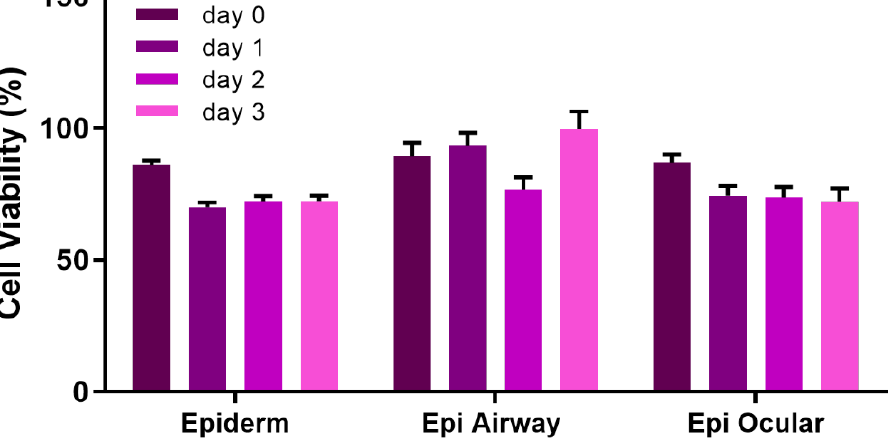
Figure 10. Viability after storage of various constructs. The indicated constructs were vitrified with DP6/VS70 in a deep-well plate and stored at < − 135 ◦ C in a vapor phase nitrogen storage freezer from 2–7 months. EpiDerm—6 months; Epi Airway—7 months; Epi Ocular—2 months. Viability was measured using the resazurin assay and is the mean ( ± SEM) of 8–12